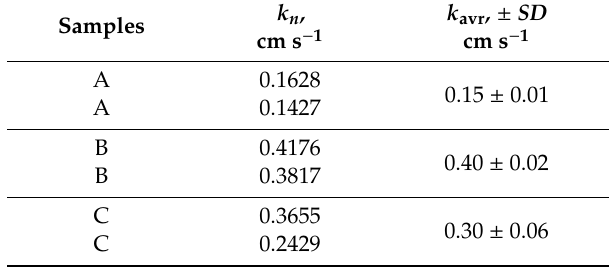
Table 2. Coe ffi cient of permeability normal to the plane k n of WD-3 nonwoven geotextile Table 2. Coefficient of permeability normal to the plane k n of WD-3 nonwoven geotextile samples.